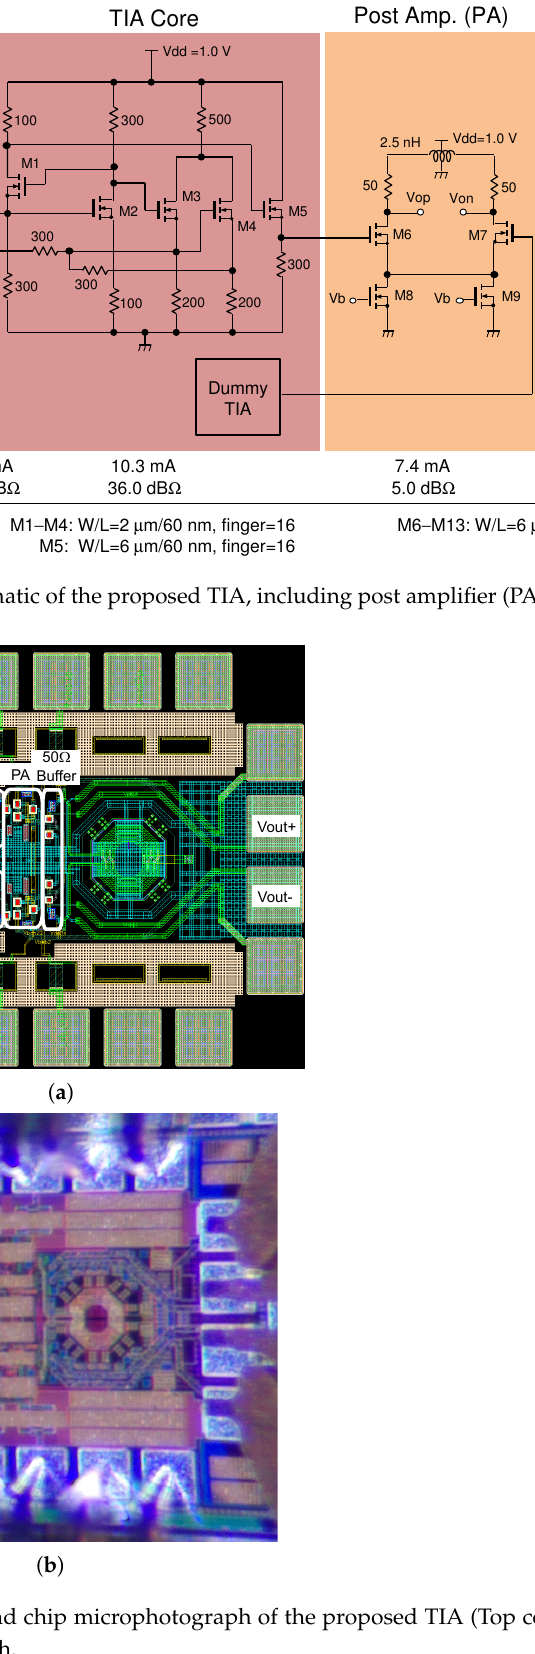
Figure 9. Layout and chip microphotograph of the proposed TIA (Top cell with pad). ( a ) Layout. ( b )